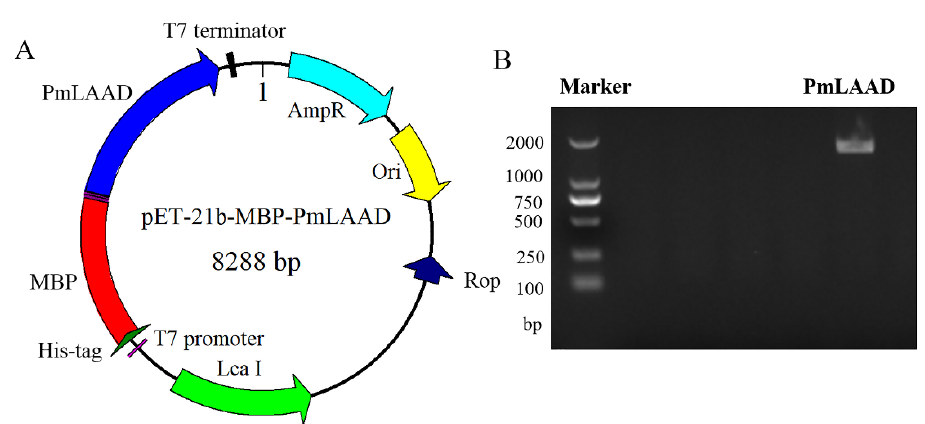
Figure 1. Construction of the recombinant plasmid of pET-21b-MBP-PmLAAD. ( A ) A schematic representation of the pET-21b-MBP-PmLAAD plasmid. The PmLAAD gene was inserted into the pET-21b-MBP vectors. ( B ) PCR amplification of the PmLAAD gene.